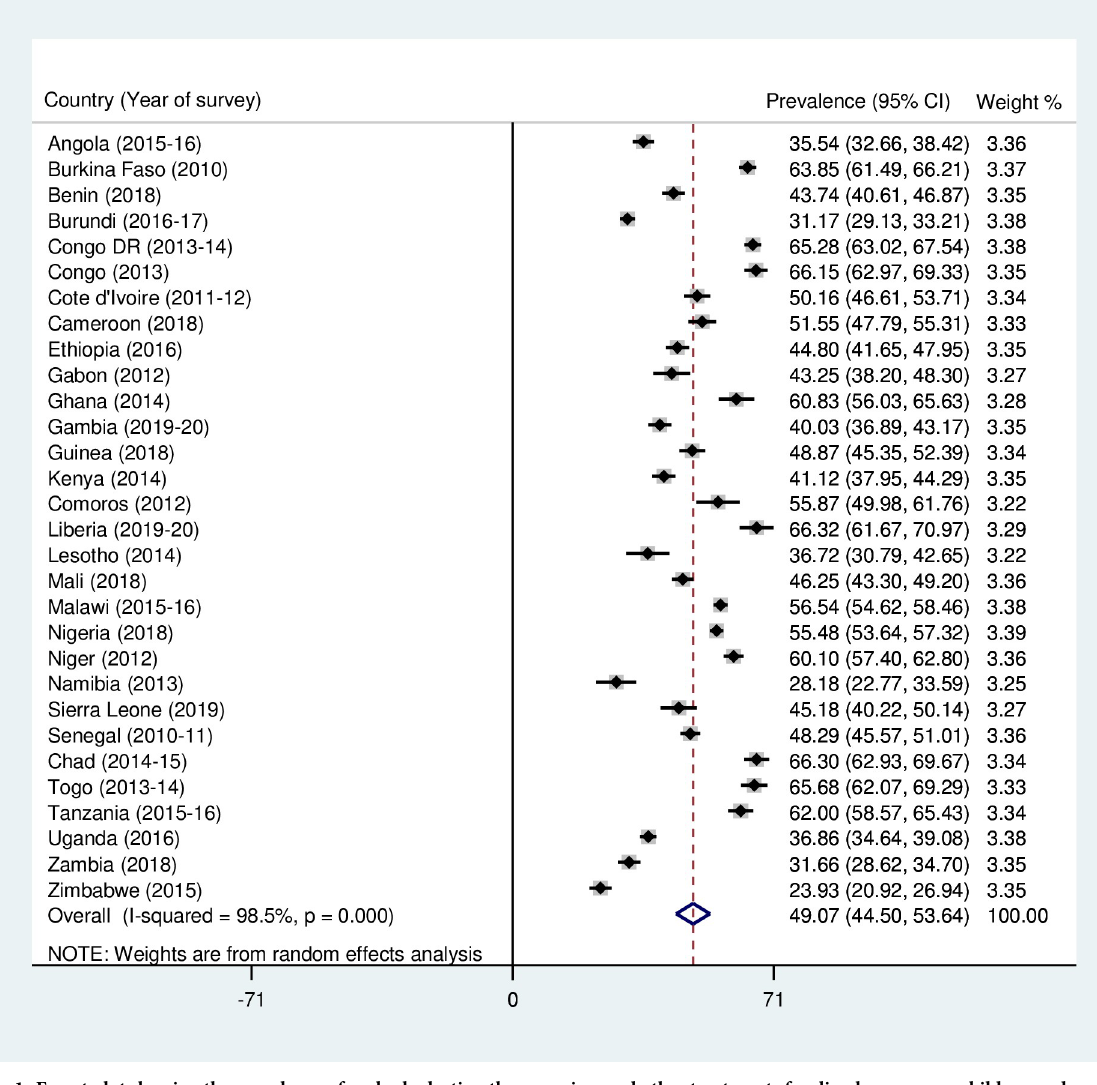
Fig 1. Forest plot showing the prevalence of oral rehydration therapy, zinc, and other treatments for diarrhoea among children under five in sub-Saharan Africa.